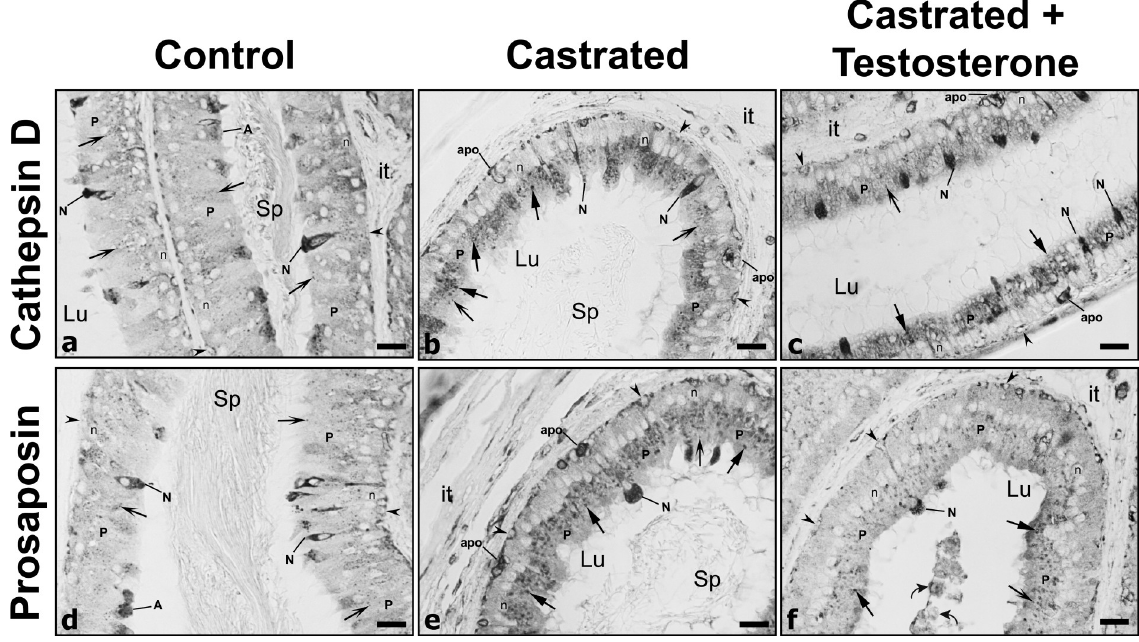
Fig 3. Immunostaining of epididymal tubules with cathepsin D and prosaposin of the initial segment from control (Con), castrated (Ct) and castrated with testosterone supplementation (Ct+T) animals. Small dense reactive spherical lysosomes (winged arrows) are seen in principal cells (P) of (Con) animals. However, lysosomes appear to be more abundant and larger in size in (Ct) and (Ct+T) animals with both antibodies, with some revealing a pale central core surrounded by a ring of dense reactivity (triangular arrows). Few basally located apoptotic bodies (apo) are evident in epithelium of (Ct) and (Ct+T) animals. The lumen of a (Ct+T) animal contains cellular debris (curved arrows). Lu, lumen; it, interstitial space; Sp, spermatozoa; reactive basal (arrowheads), narrow (N) and apical (A) cells; n, nuclei of principal cells. Scale bars = 25 μ